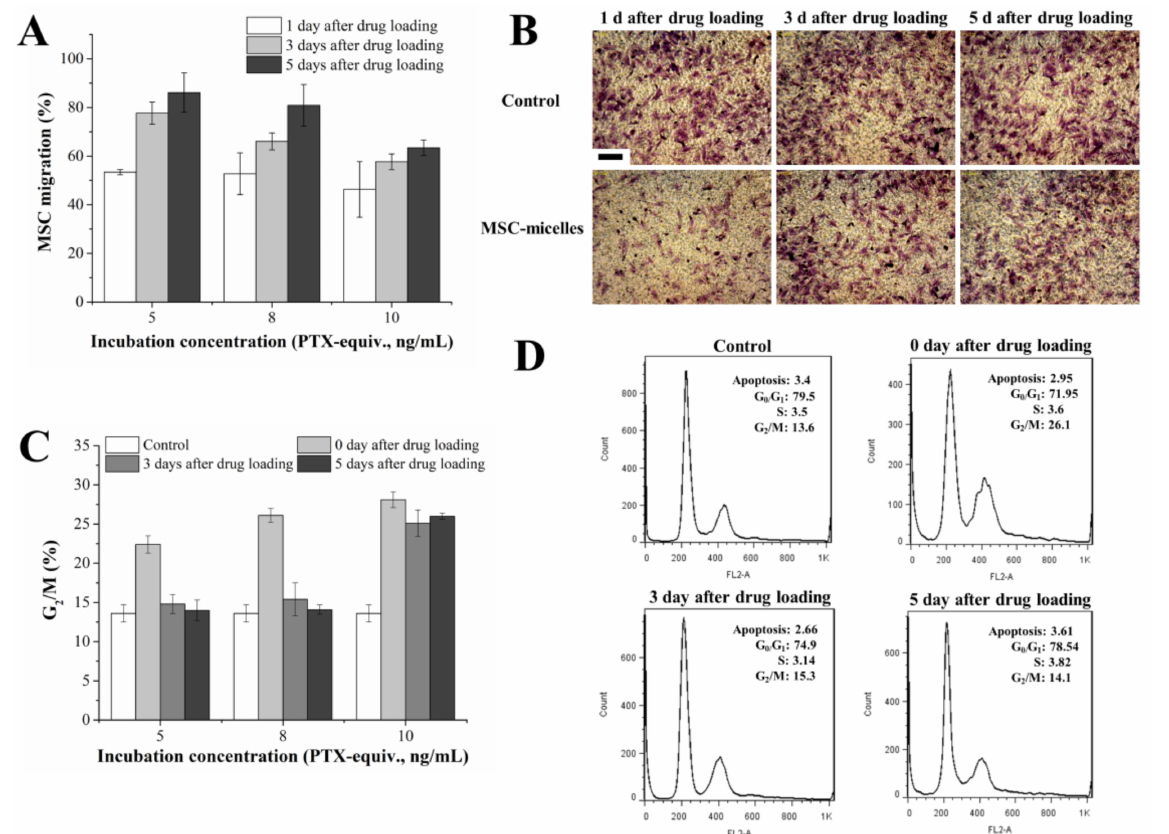
Figure 4. ( A ) Migratory activity of MSC-micelles with different drug loading and recovery times. The numbers of the migrating MSCs were counted. Cells incubated with the blank micelles were set as the control. ( B ) Representative images of migrated MSCs incubated with 8 ng/mL PTX/HA-PLGA micelles through the membrane pores; 1, 3, 5 days after MSC-micelles seeding to the upper chamber of the transwell system, the migrated MSCs were stained by crystal violet (bar = 300 µ m). ( C ) The percentage of MSC-micelles arrested in G 2 /M phase 0, 3, 5 days after incubation with 5, 8, 10 ng/mL PTX/HA-PLGA micelles. ( D ) Cell cycle analysis of MSCs recovered from exposure to 8 ng/mL PTX/HA-PLGA